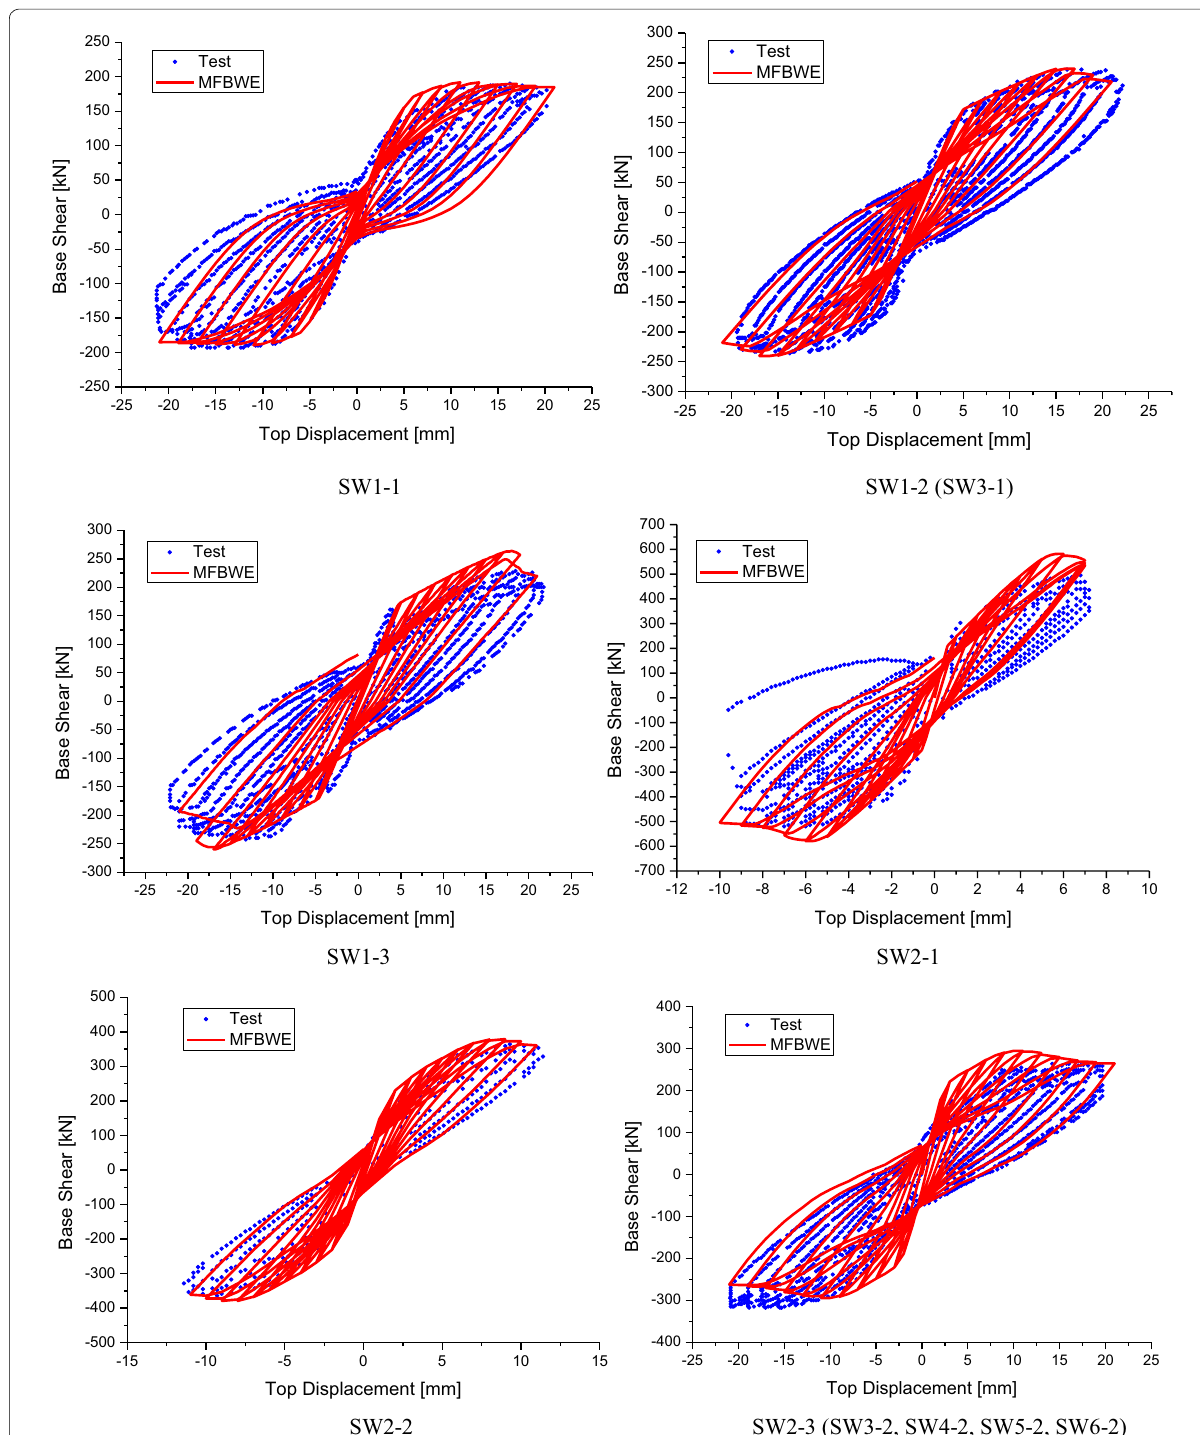
Fig. 11 Comparisons between the experimental data and the analytical results using the proposed